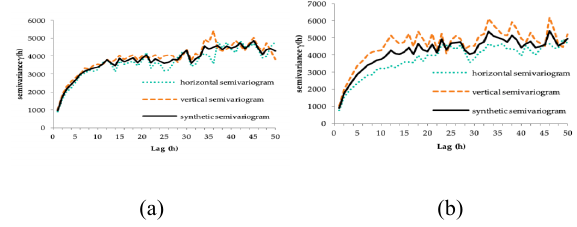
Figure 6. Semivariogram of the experimental images. (a) Urban